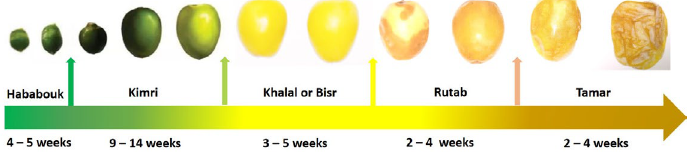
Figure 1. Different growth and maturity stages of Barhi date fruit (post-anthesis weeks) [1].